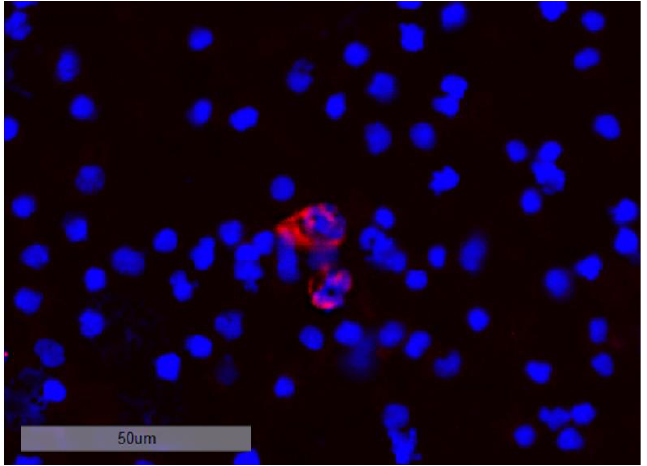
Figure 9. DTC cluster consisting of two cells staining positive for CK at 20-fold